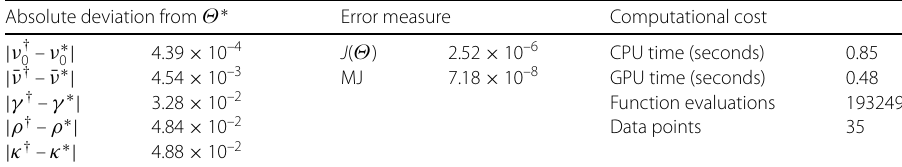
Table 8 Performance of Heston–CaNN calibrating 5 parameters on a GPU over 3125 × 5 (random seeds) test